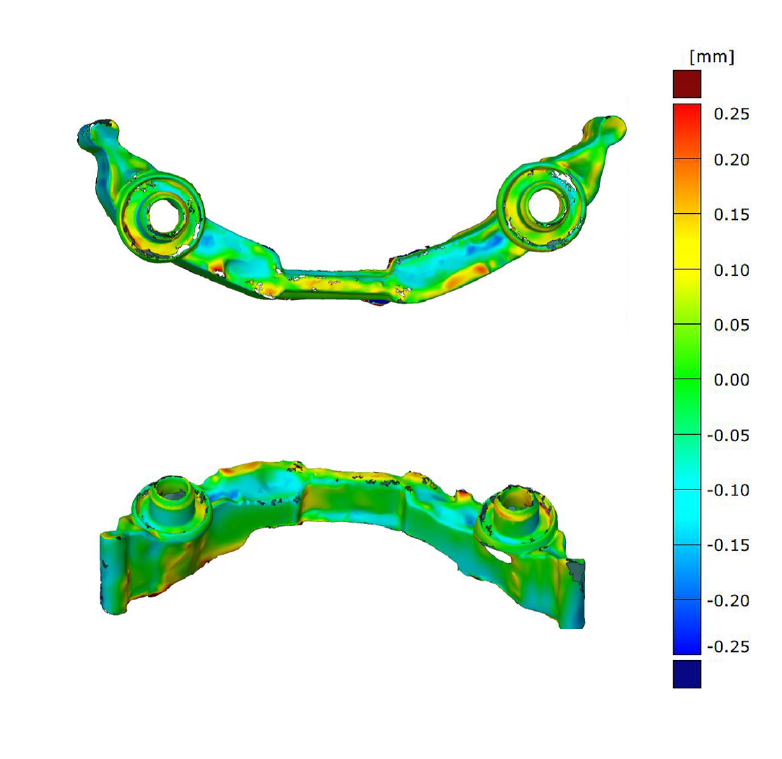
Figure 8. Nominal/actual value comparison of the dental framework—top view (above) and side view